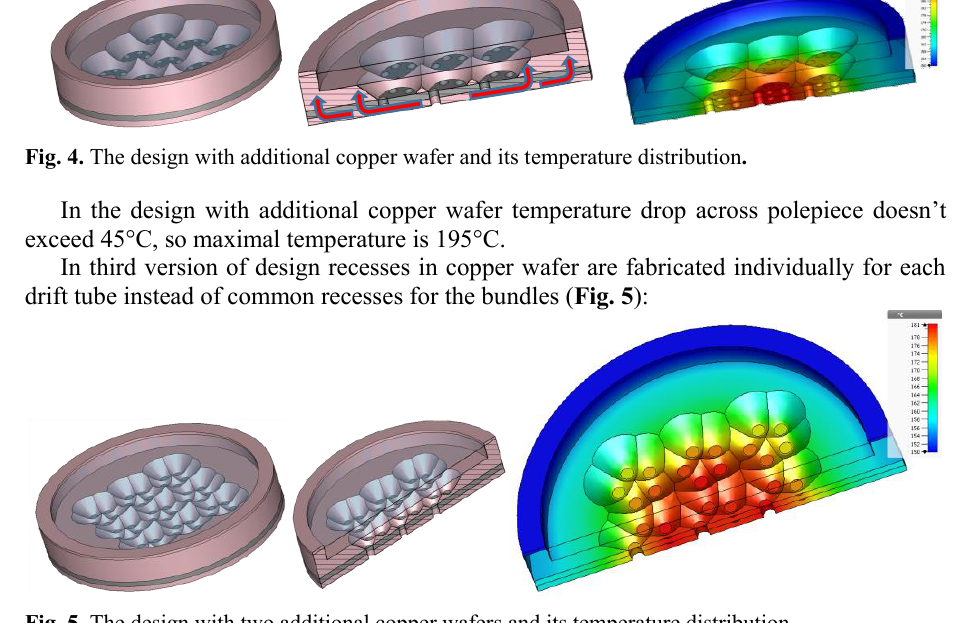
Fig. 5. The design with two additional copper wafers and its temperature distribution